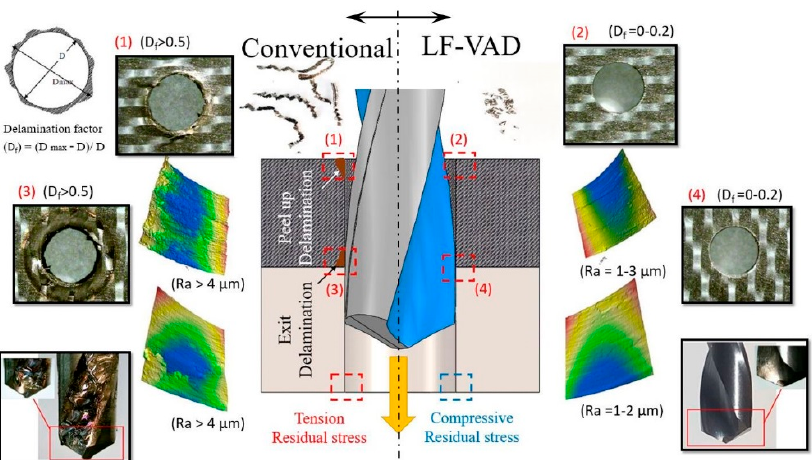
Figure 1. The effect of low-frequency vibration-assisted drilling (LF-VAD) and conventional drilling CD on the chip morphology, surface integrity, and drill tool during the drilling process of CFRP/Ti6Al4V stack material [38].